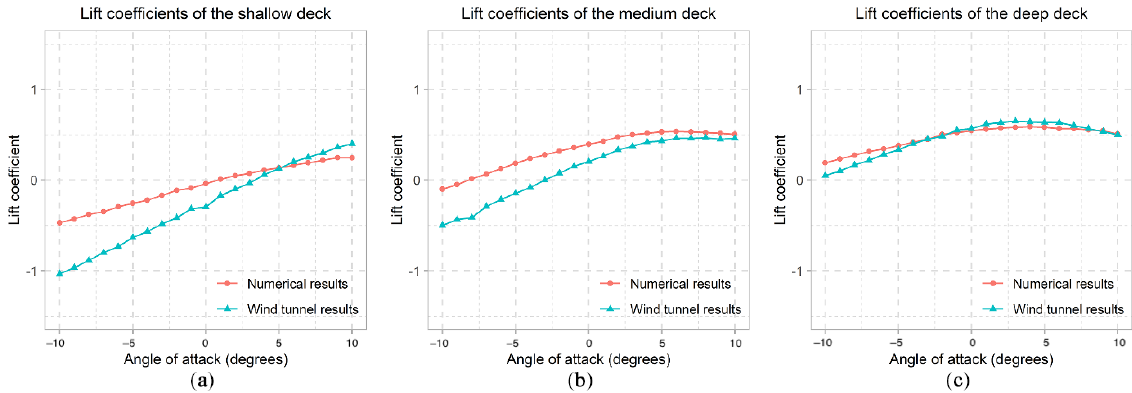
Figure 21. Lift coefficients of different bridge decks: ( a ) the shallow deck; ( b ) the medium deck; ( c ) the deep deck.